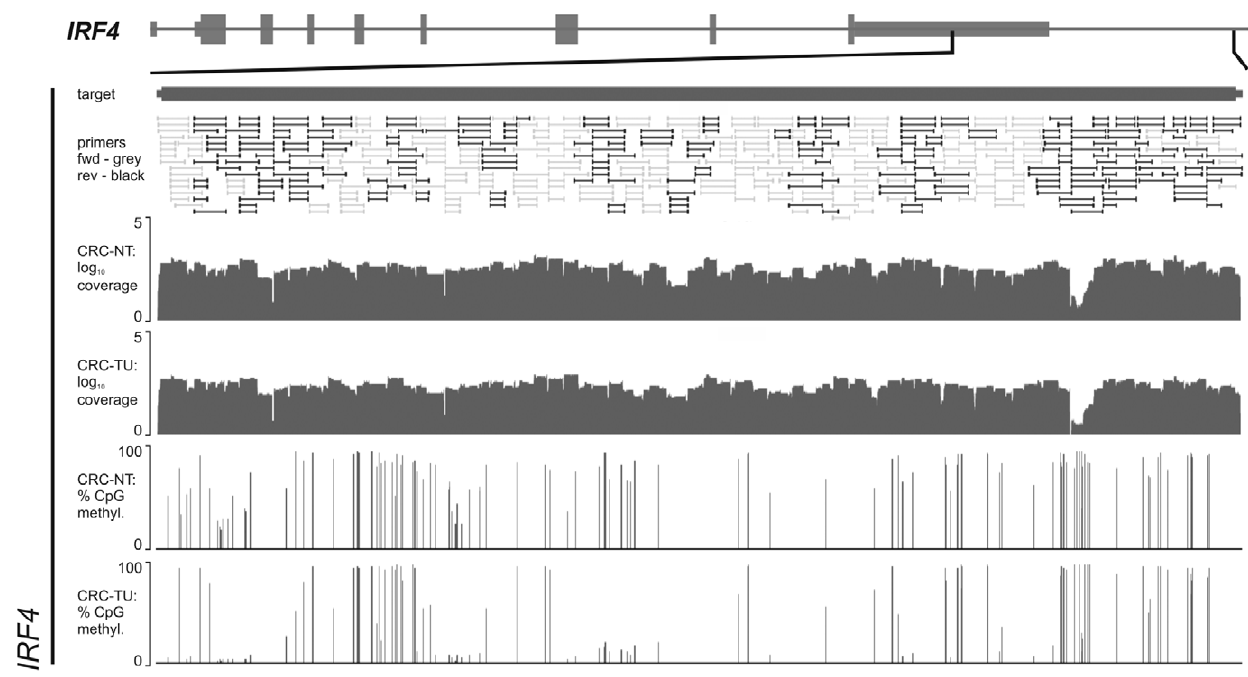
Figure 3. The Figure gives an overview of the amplicon and primer positions of the design, coverage and CpG methylation for the hepityping region IRF4 (panel B, chromosome 6 from 352,937–366,151 bp). The location relative to the gene model, the primer positions, the log10 coverage and the percentage of methylation for the two colorectal cancer samples are plotted as a function of the genomic coordinates.